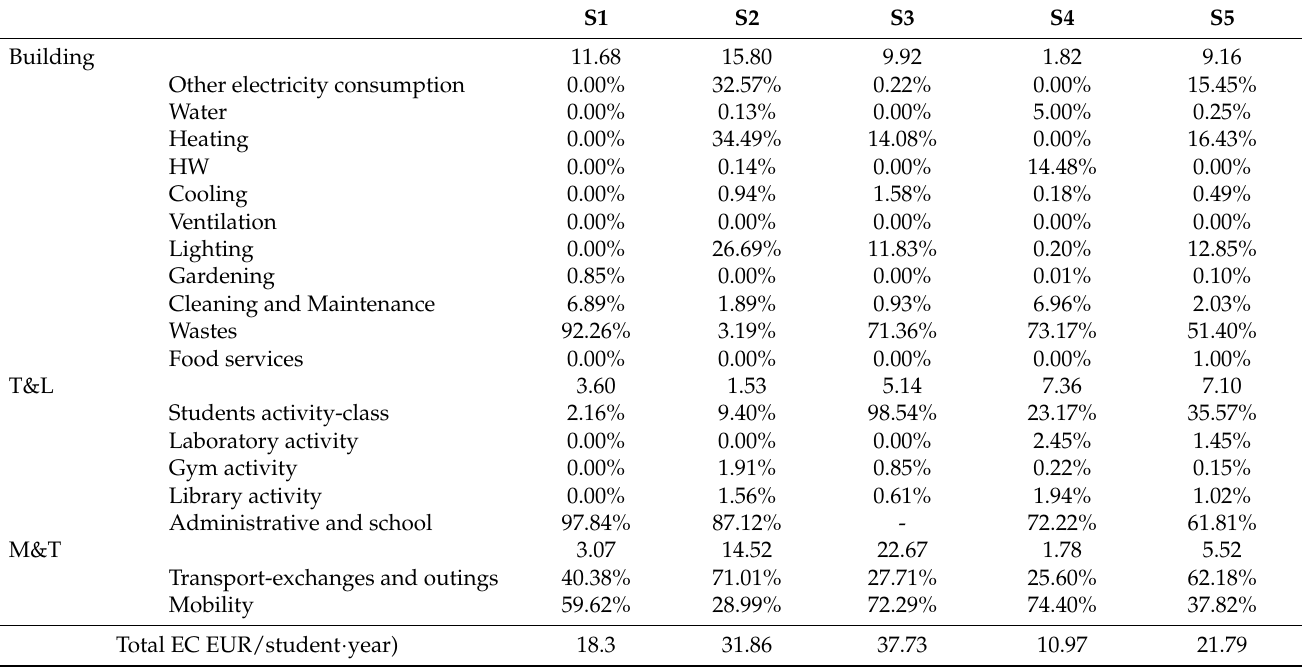
Table 11. External costs impact results per school, subsystem, and